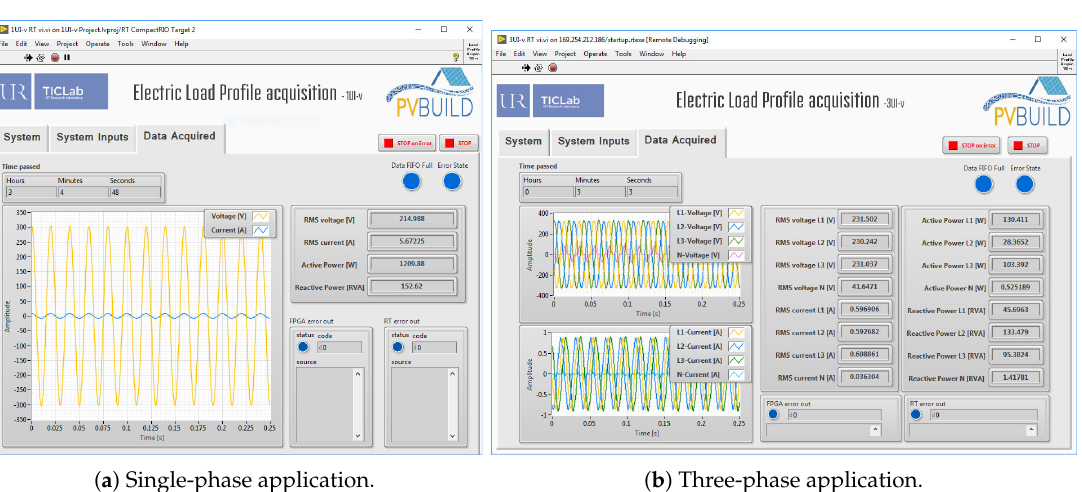
Figure 7. User Interfaces of the electric load profile acquisition applications running under several parameters.